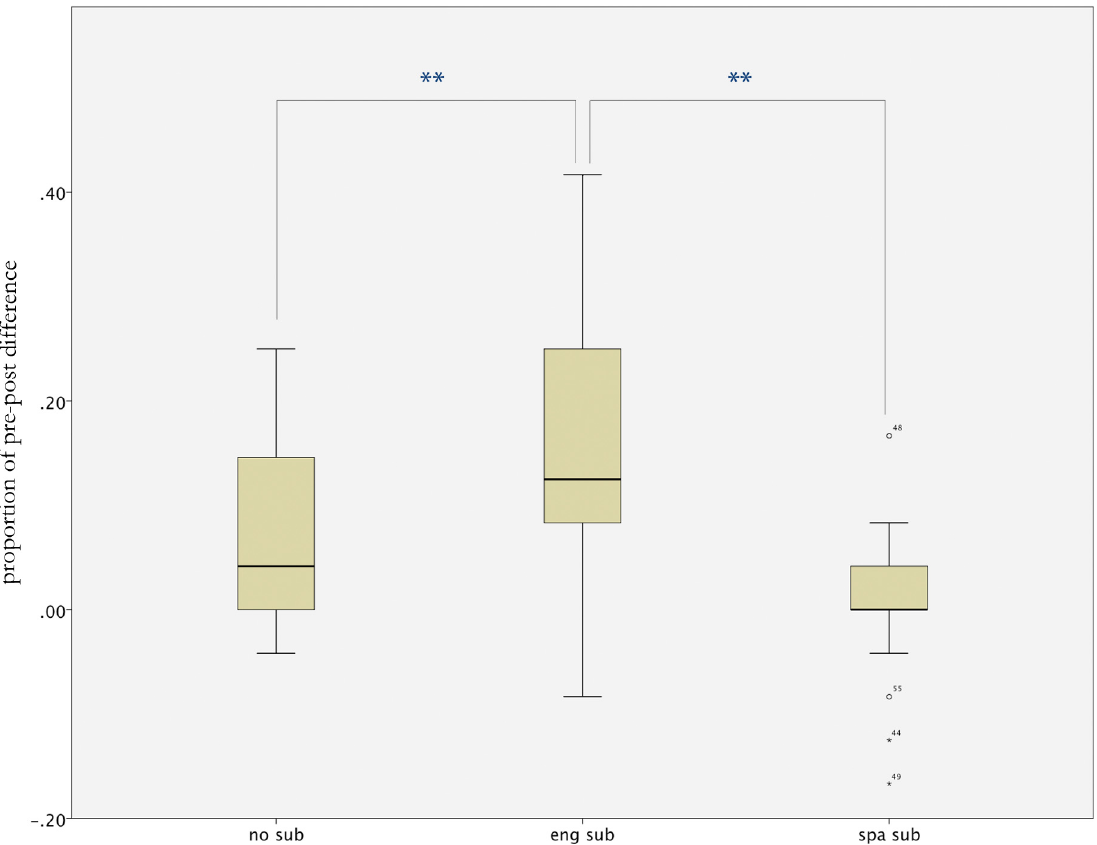
Fig 1. Listening test results. Bonferroni-corrected T-tests for pre-post differences in performance, in the listening test. * < 0.05; ** < 0.01. The English subtitles condition was found to lead to steeper improvements in performance (+4.05 items; 16.9% increase), compared to the no subtitles condition (+1.7 items; 7.1% increase) and to the Spanish subtitles (0.0% increase).